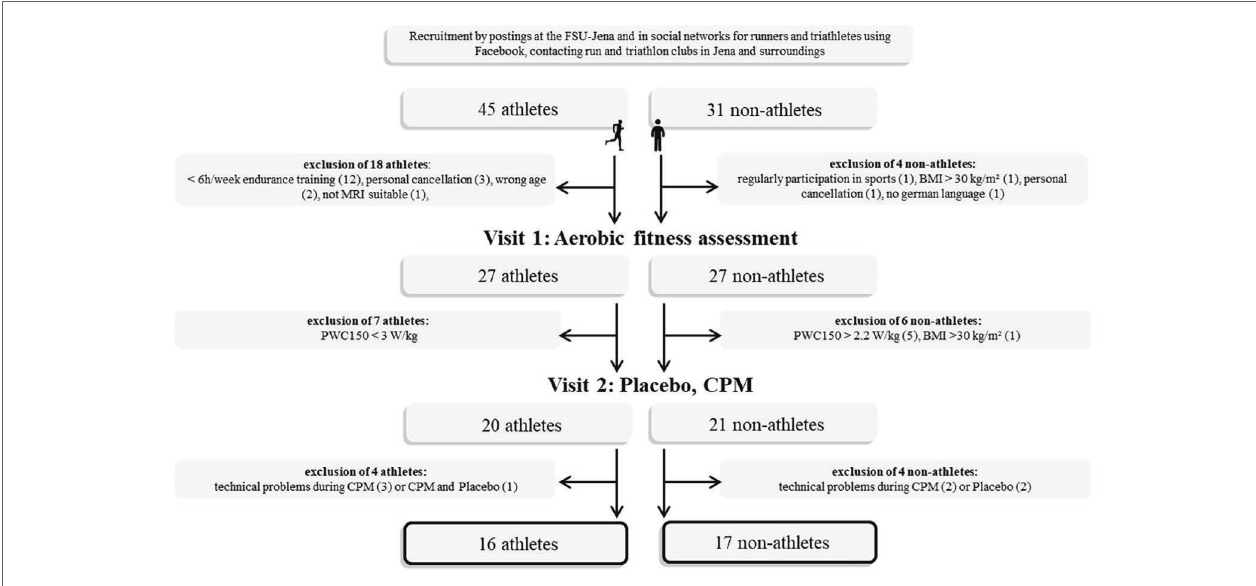
FIGURE 1 | Flow chart of data acquisition. FSU, Friedrich-Schiller-University; PWC, physical work capacity; CPM, conditioned pain modulation; BMI, body mass